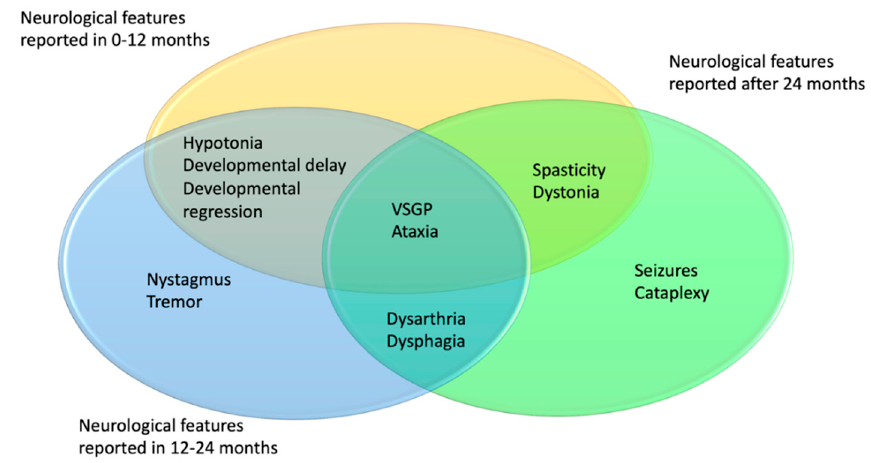
Figure 4. Distribution of age of onset for the neurological symptoms in NPC1 patients. In yellow 0–12 months, blue 13–24 months, green 24+ months.